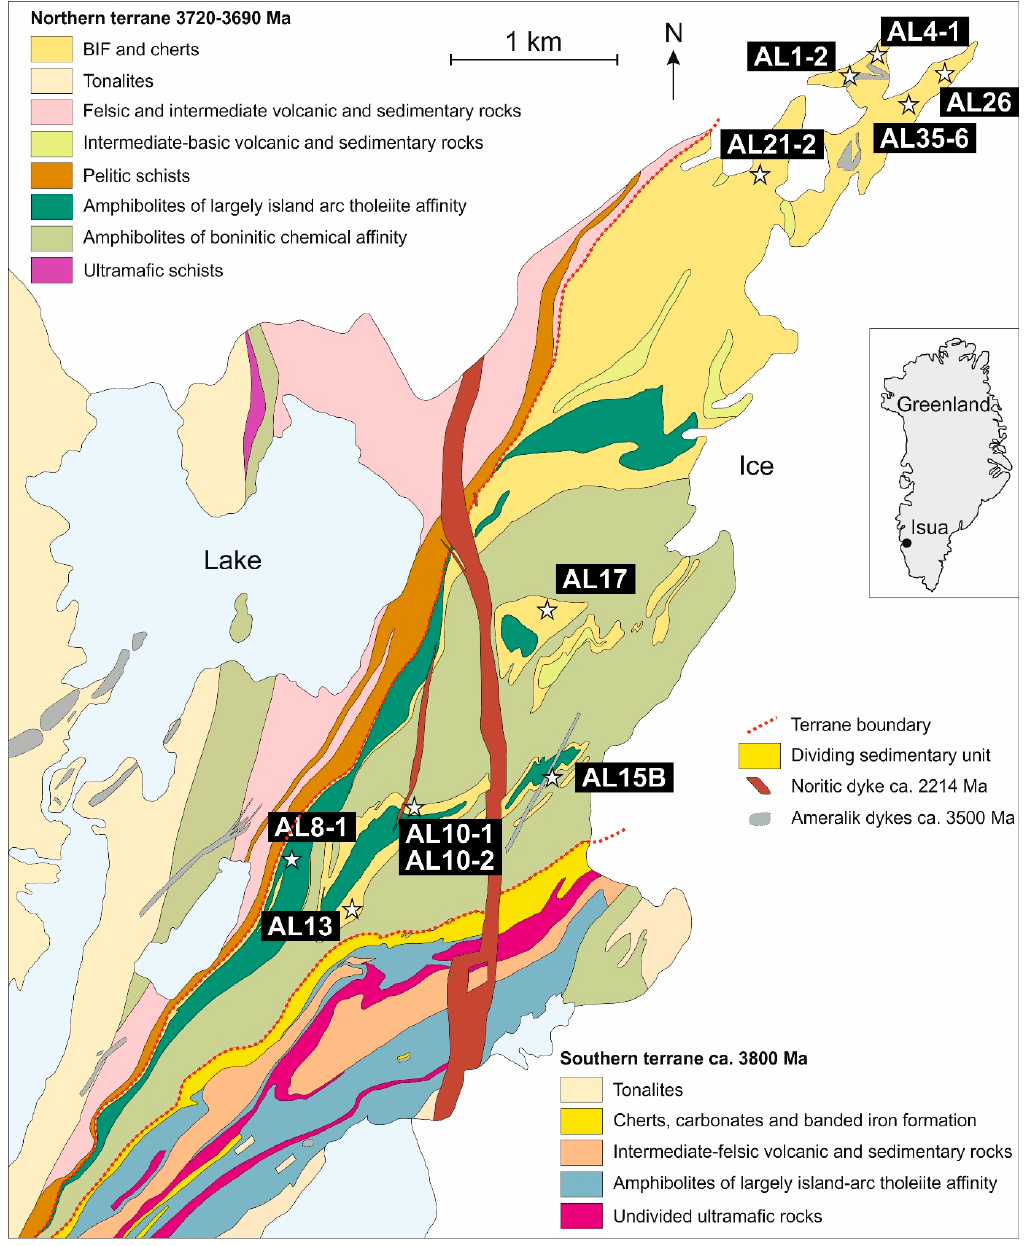
Figure 1. Simplified geological map of the Isua supracrustal belt, adapted from Nutman and Friend [58], Lepland et al. [22], and Wudarska et al. [27], showing our 11 sampling locations. For geographic coordinates, see Lepland et al. [22].